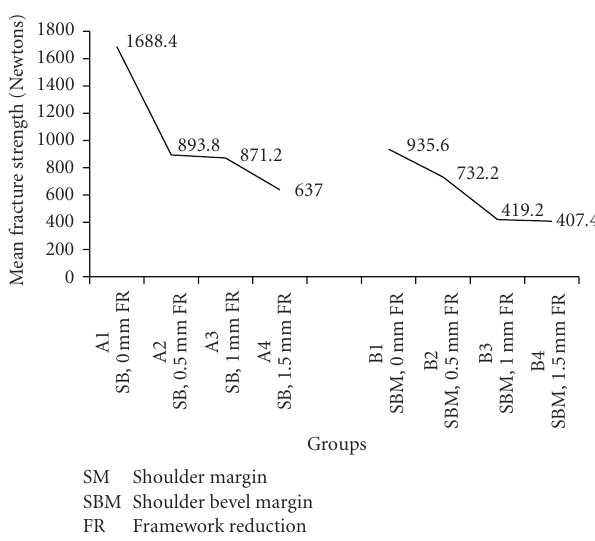
Figure 7: Comparison between mean fracture strength of A and B